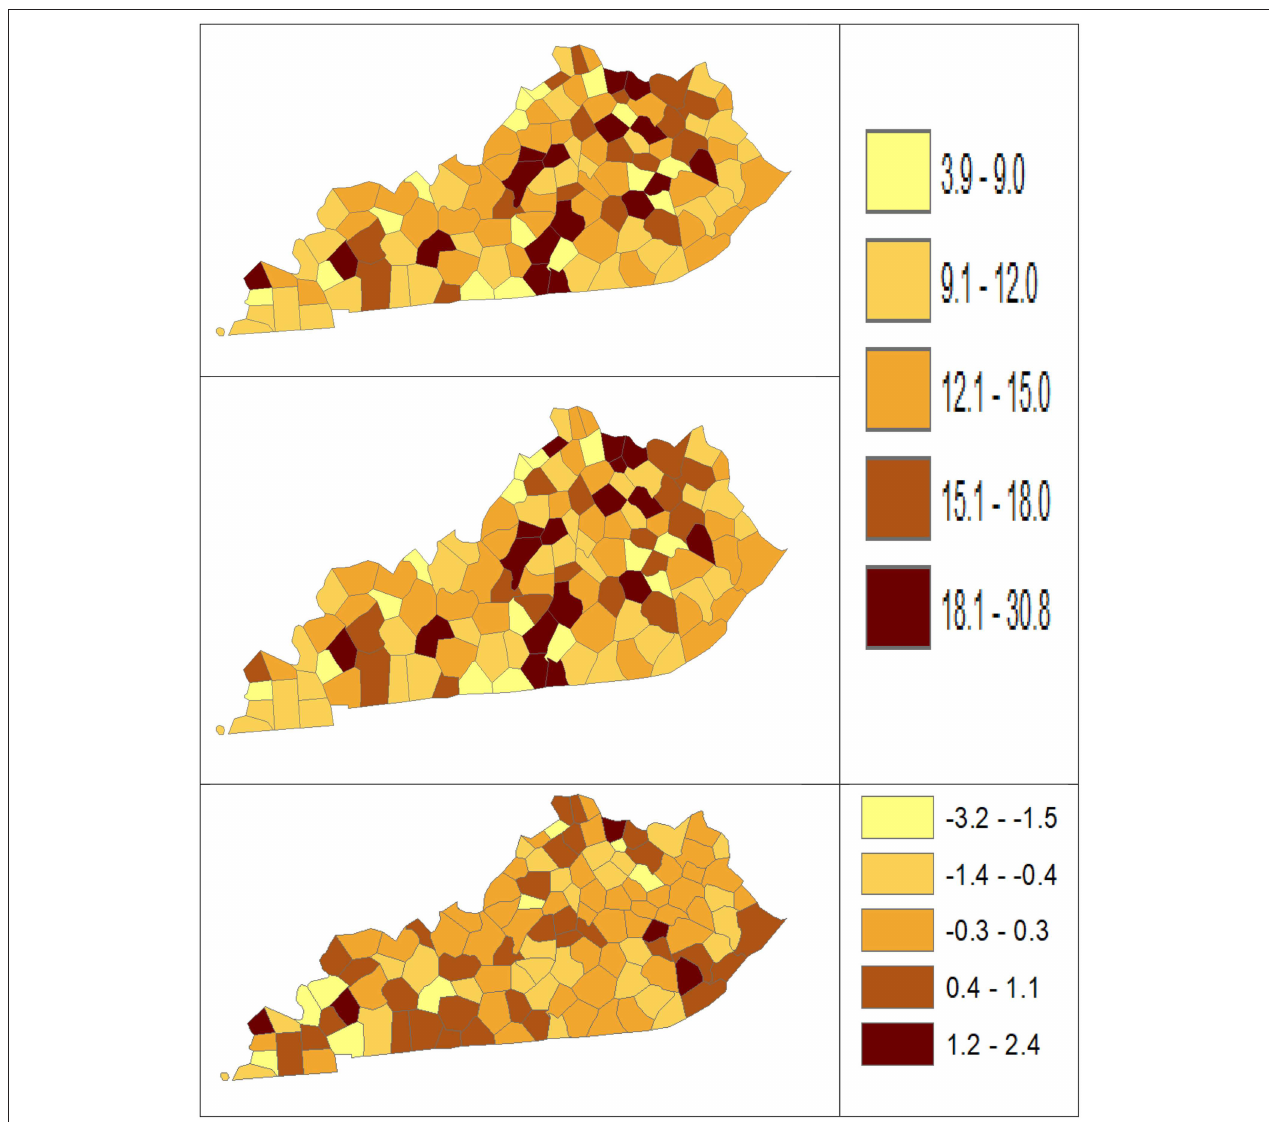
FIGURE 3 | Age-Adjusted Rate estimated from statistical methods (Direct top vs. BCM middle) and their difference (bottom) using 2006–2010 oral cancer incidence